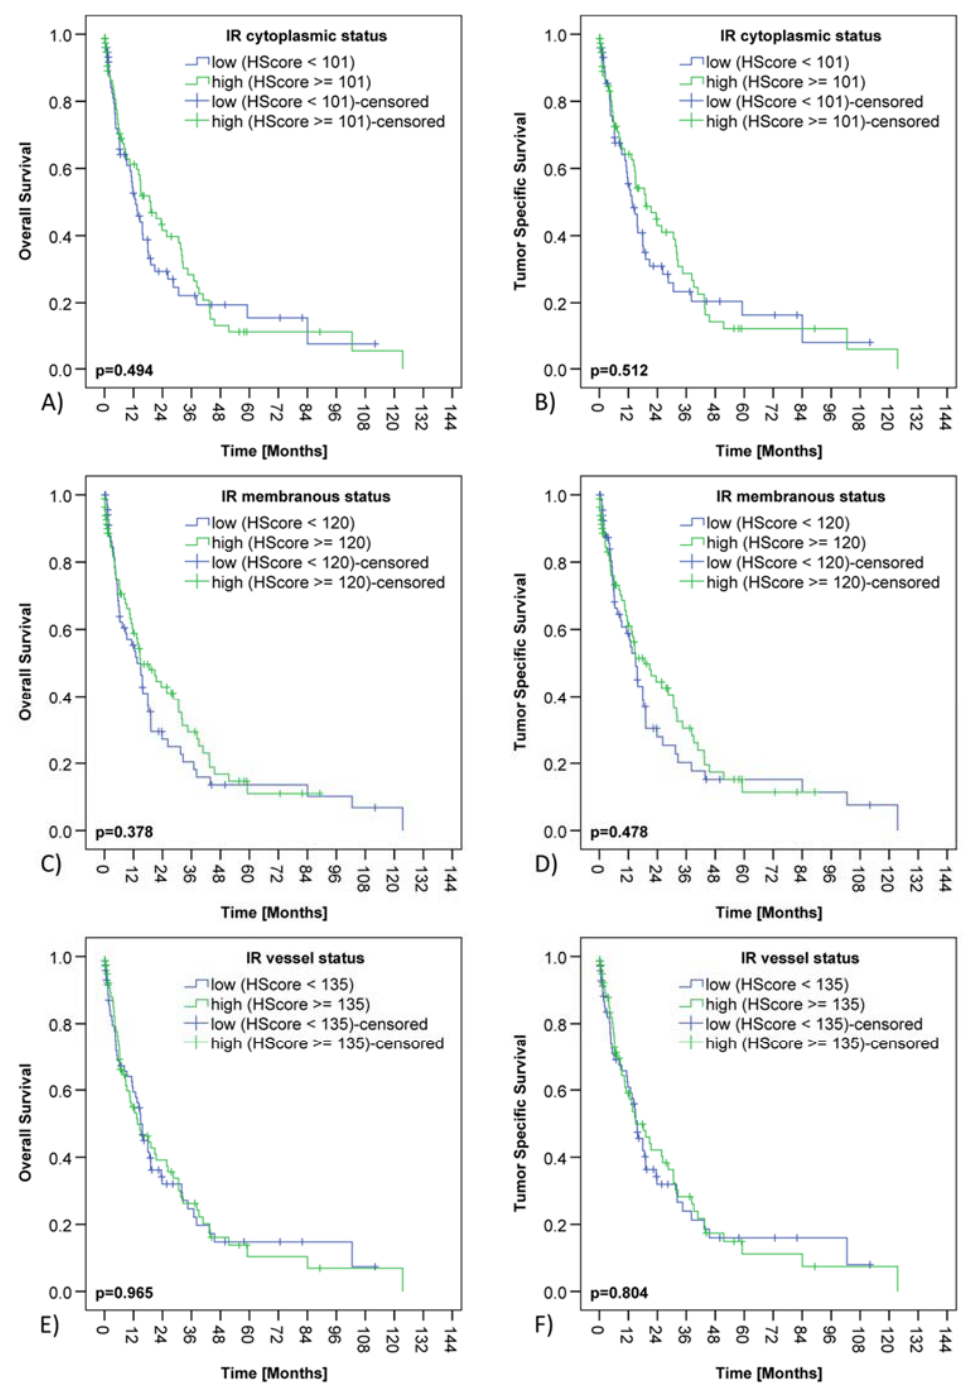
Figure 3. Insulin receptor expression and survival of PDAC patients. Kaplan–Meier curves demonstrating correlations between cytoplasmic insulin receptor expression in cancer cells (cCC-IR) and overall ( A ) ( p = 0.494) as well as tumor specific survival ( B ) ( p = 0.512). Kaplan–Meier curves showing correlations between membranous insulin receptor expression in tumor cells (mCC-IR) and overall ( C ) ( p = 0.378) as well as tumor specific survival ( D ) ( p = 0.478). Kaplan–Meier curves depicting correlations between insulin receptor expression in tumor vasculature (VIR) and overall ( E ) ( p = 0.965) as well as tumor specific survival ( F ) ( p = 0.804).